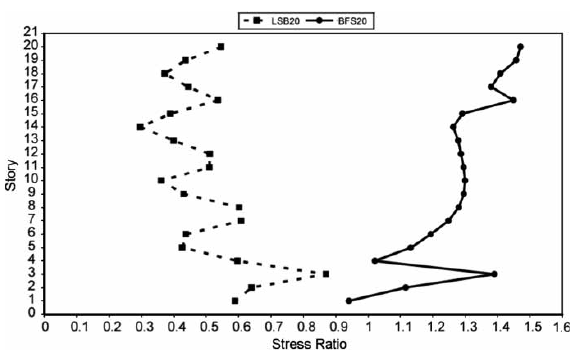
Fig. 22. Summation of the stress ratios in the beams of all models in each story